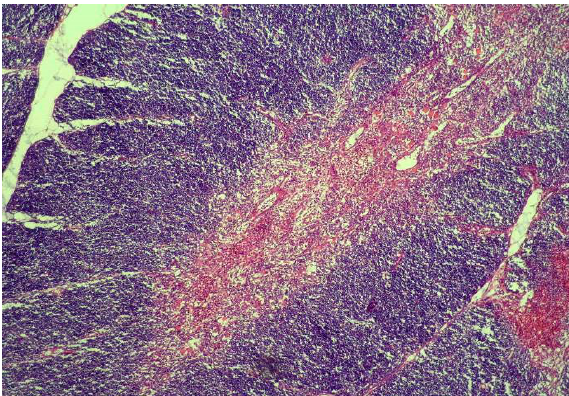
Fig. 1. The structure of the broiler chicken’s thymic lobule is preserved in the 1 st group on the 30 th day of the Fig. 2 . Broiler chicken’s thymus, the 2 nd group, the 30 th day test. H&E. x 100 of the test. The division into the thymic cortex and medullar is well expressed. H&E. x 100 The density of their placement in the field of view was higher in the 1 st , 2 nd , and 3 rd group on the 30 th day and was, respectively, 140.2 ± 19.2; 131.7 ± 17.0; 112.4 ± 14.9, com- pared with the control group (98.7 ± 13.2). On the 15 th